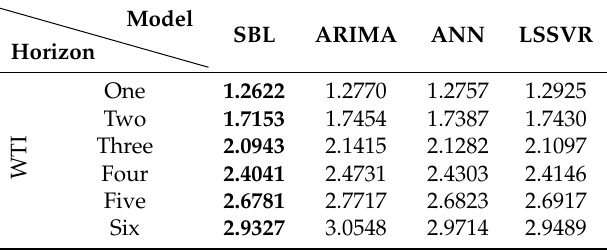
Table 2. The RMSE values by different single models on WTI and Brent crude oil prices.